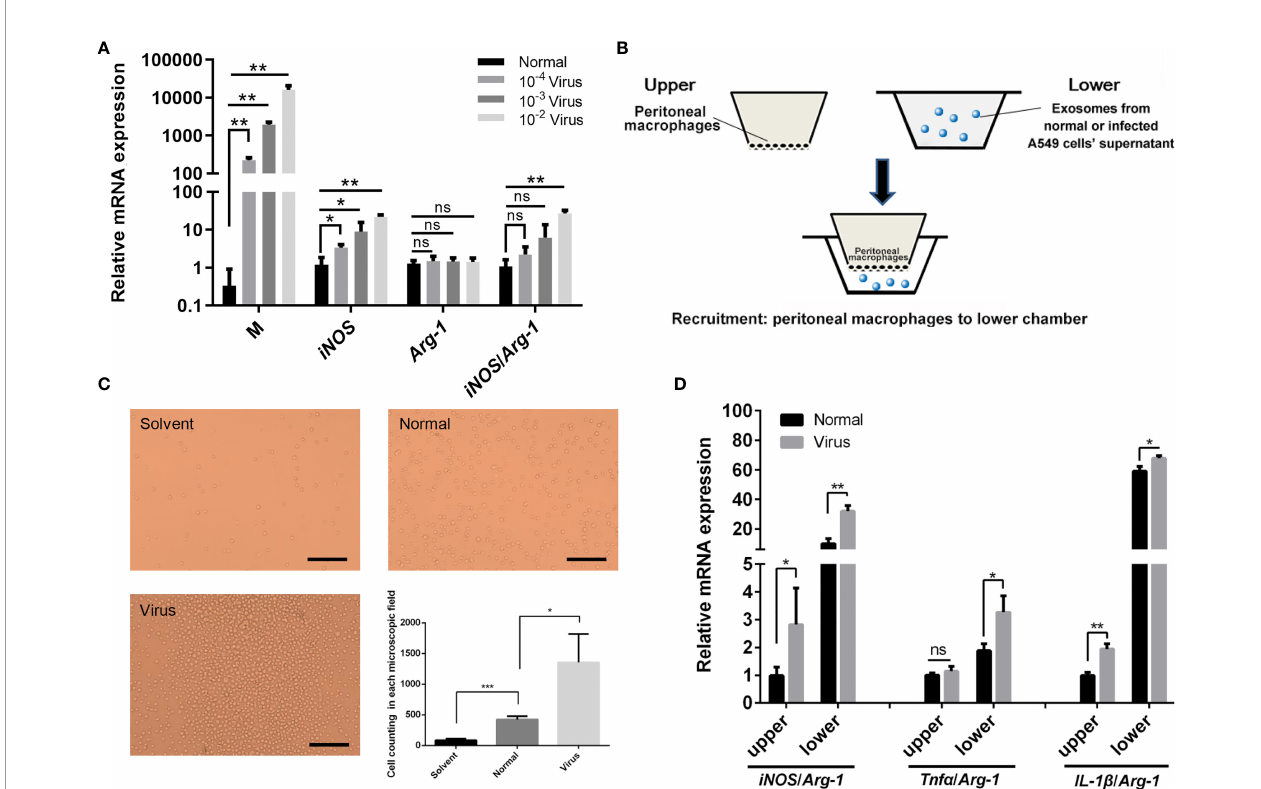
FIGURE 5 | Effects of H1N1 virus infection and exosomes on the polarization and recruitment of peritoneal macrophages. (A) Mouse peritoneal macrophages were infectedwith a gradient dilution (10 -2 , 10 -3 , 10 -4 ) of the H1N1 virus, and total RNA was isolated for the transcriptional analyses of In fl uenza virus M , iNOS, Arg-1 genes. N = 3, * p < 0.05 and** p < 0.01. (B) Schematicdiagram of the transwellassay in order to investigate the recruitment of peritoneal macrophages by exosomes. The upper chambers were covered with peritoneal macrophages, andthe lower chambers were supplemented with a fresh culture medium(solvent group) or the medium containing exosomes from normal orinfected A549 cell ’ supernatant (normal orvirus groups). (C) Cells in the lower chamberswere microscopically observed andcounted at 24 h after adding exosomes. Scalebar: 50 m m. (D) Total RNA was isolated from peritoneal macrophages inthe upper and lower chambersat 24 h after adding exosomes and employed for transcriptional analysis of iNOS , Tnf a , IL-1 b , Arg-1 genes . N ≥ 3, *p < 0.05, **p < 0.01 and***p< 0.001. ns, nosigni fi